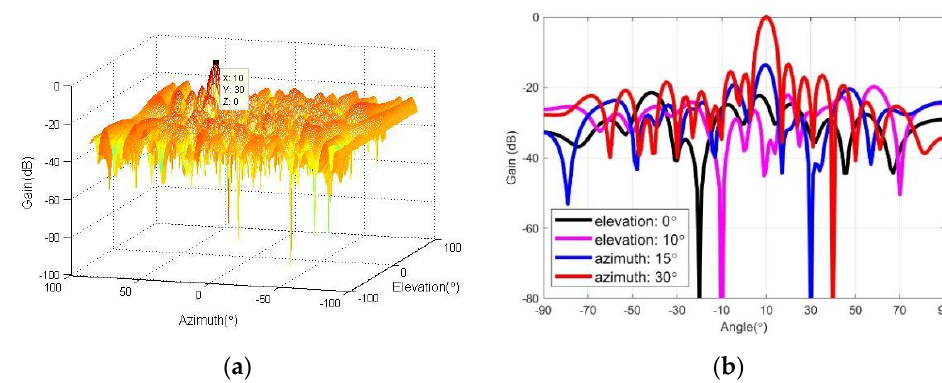
Figure 4. Array beampattern. ( a ) three dimensional beampattern; ( b ) section view of array beampattern.